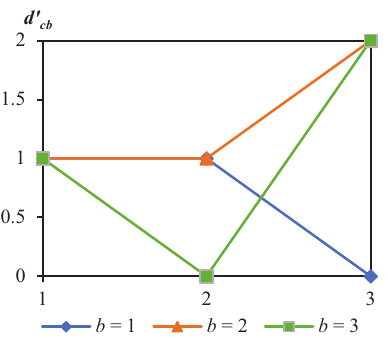
Figure 4. Graphical representation of core competence grading